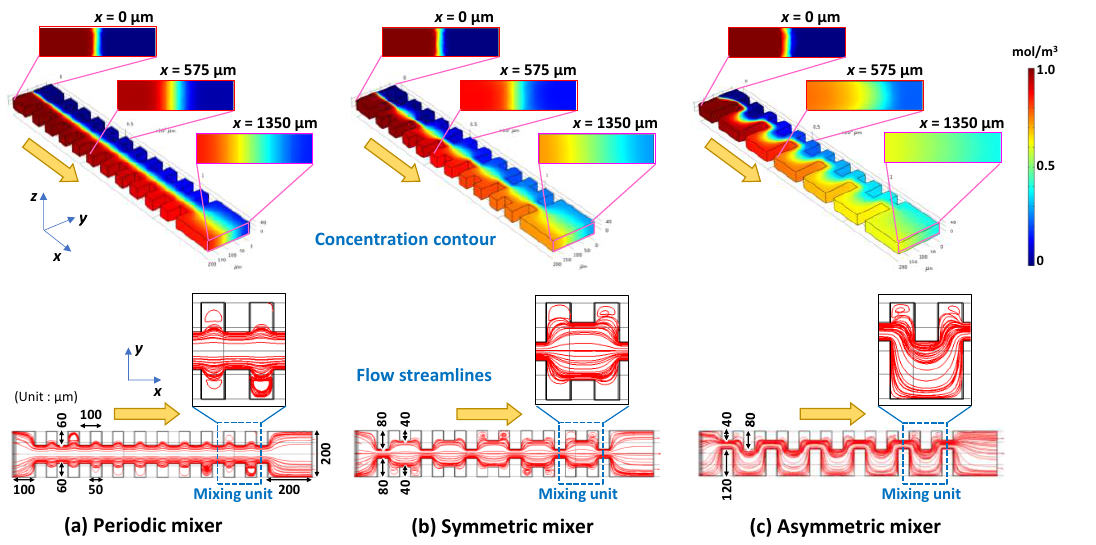
Figure 1. Simulation results showing the flow streamlines and concentration contours of two different fluids (with a concentration of 0 and 1 mol/m 3 ) in three types of planar micromixers with different types of simple vertical obstacle structures at a flow velocity of 8.3 × 10 –3 m/s each (equivalent to a total flow rate of 10 µL/min and Re = 1.3). ( a ) Periodic mixer with periodic rectangular obstacle structures; ( b ) symmetric mixer with two types of symmetric obstacle structures alternately arranged with two different gap distances; ( c ) asymmetric mixer with two types of asymmetric obstacle structures alternately arranged with two different gap distances.